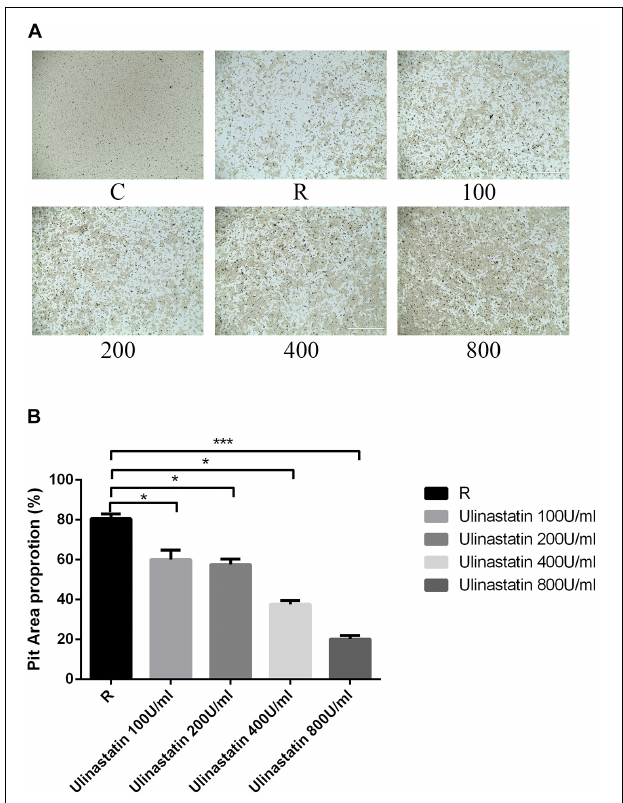
FIGURE 4 | Ulinastatin prevents bone resorption function of osteoclasts. C represents control group, R represents RANKL group, 100 ∼ 800 represents RANKL + 100 units/mL ulinastatin ∼ RANKL + 800 units/mL ulinastatin group. (A,B) BMMs (1 × 10 4 cells/well) were seeded onto a Corning Osteo Assay Surface and cultured with M-CSF (30 ng/mL) and RANKL (100 ng/mL) for 4 days and then treated with four different concentrations of ulinastatin (100, 200, 300, and 400 units/mL) for another 4 days. Then the images were acquired and pit area was quantified. Data are presented as means ± SD of three independent experiments; ∗ P < 0.05; ∗∗ P < 0.01; and ∗∗∗ P < 0.001 versus RANKL